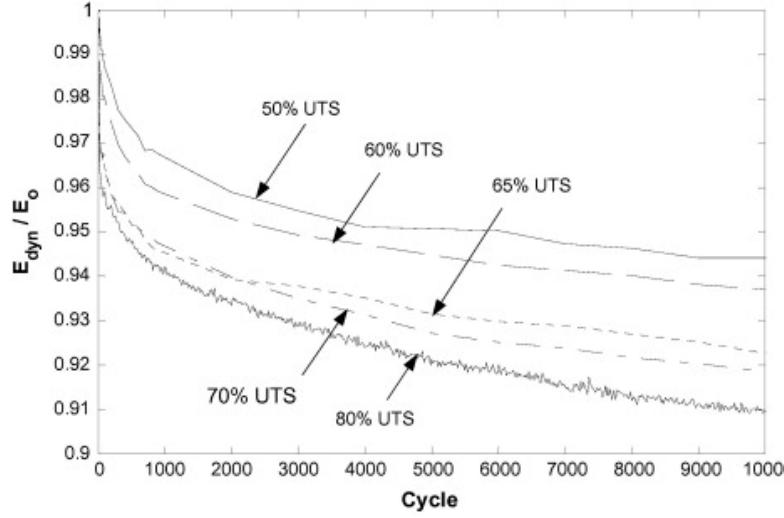
Figure 16. An exemplary demonstration of normalized stiffness reduction under stress ratios of one-half or above (0.5 ≤ R ≤ 0.8), adapted with permission from Ref. [74]. Copyright © 2013 Elsevier Ltd.